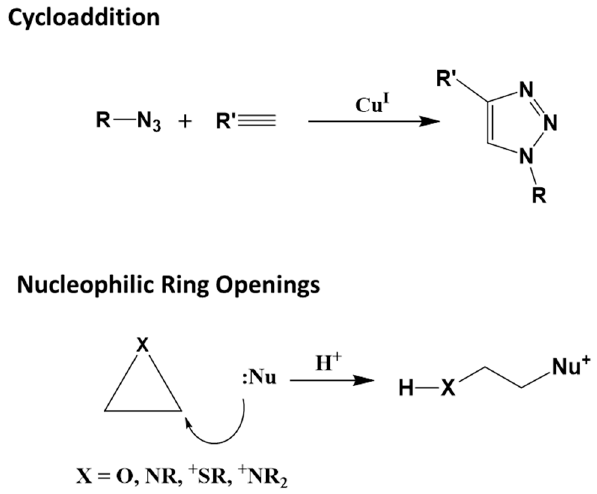
Figure 14. Cycloaddition and nucleophilic ring-opening click chemistry reactions. Non-aldol carbonyl click reactions are reactions that result in the formation of hydra- zones, ureas, oximes, amides, thioureas and aromatic heterocycles, among others. Generally, these reactions have high thermodynamic forces, allowing products to be obtained more quickly, which decreases the likelihood of byproduct formation [157]. Examples of reaction schemes of this class can be seen from Figure